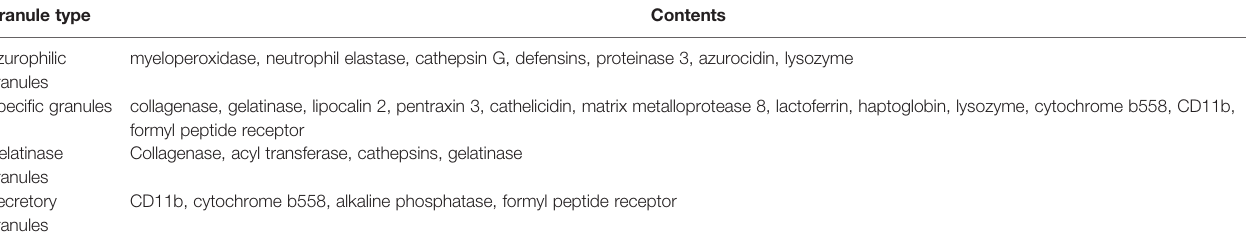
TABLE 1 | Types of neutrophil granules and their